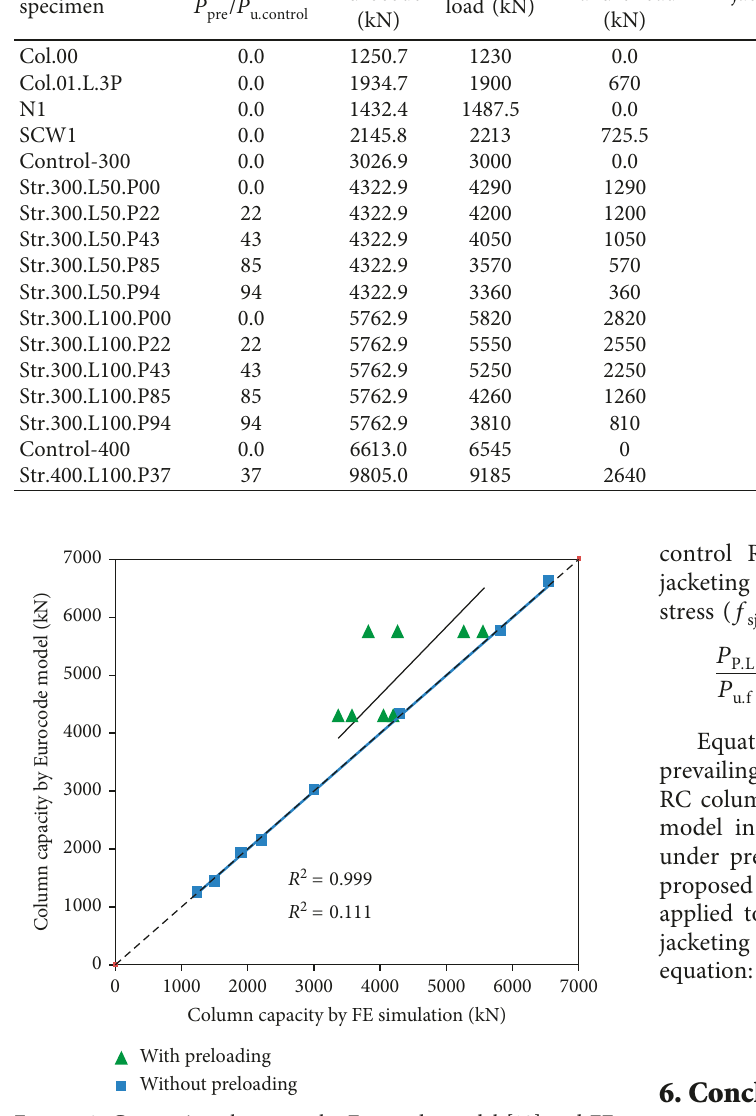
Table 4: Summary of RC columns strengthened with steel jacketing in the present study. Column specimen